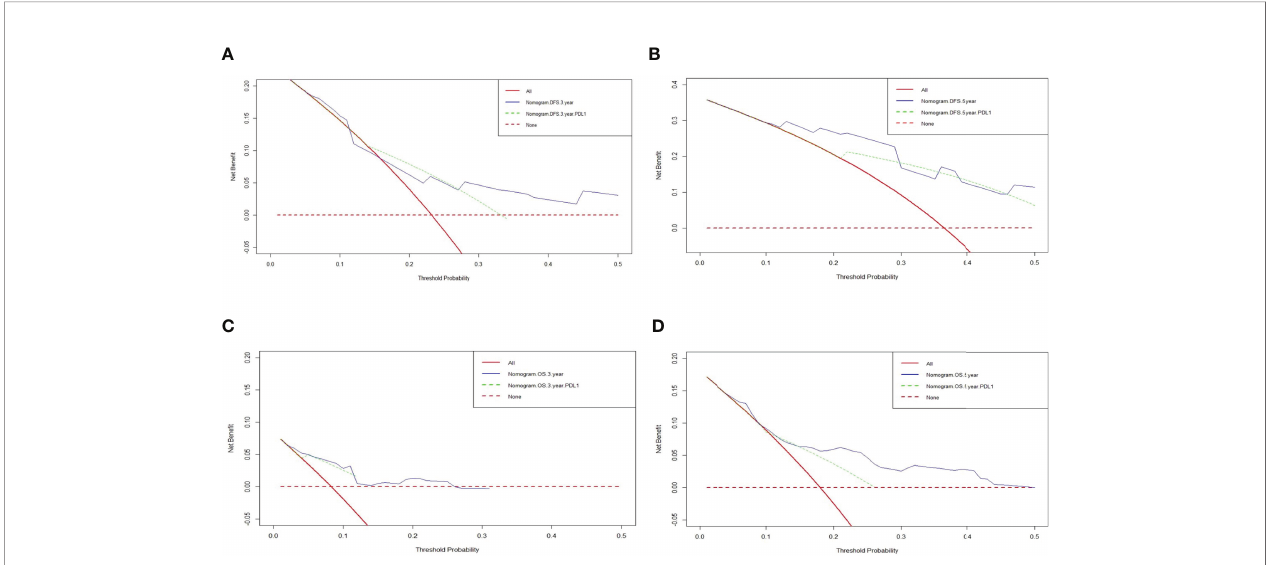
FIGURE 4 | Decision curve analysis (DCA) of the nomograms and PD-L1 for predicting the disease free survival (DFS) and overall survival (OS). The X-axis represents threshold probability, and the Y-axis shows net bene fi t. The lines between the X-axis and the Y-axis display the bene fi t of different predictive variables. The red dotted line suggested that no patient has a poor prognosis, while the red line indicated that all patients have a poor prognosis. (A) DCA of the nomograms and PD-L1 for predicting the 3-year DFS; (B) DCA of the nomograms and PD-L1 for predicting the 5-year DFS; (C) DCA of the nomograms and PD-L1 for predicting the 3-year OS; (D) DCA of the nomograms and PD-L1 for predicting the 5-year